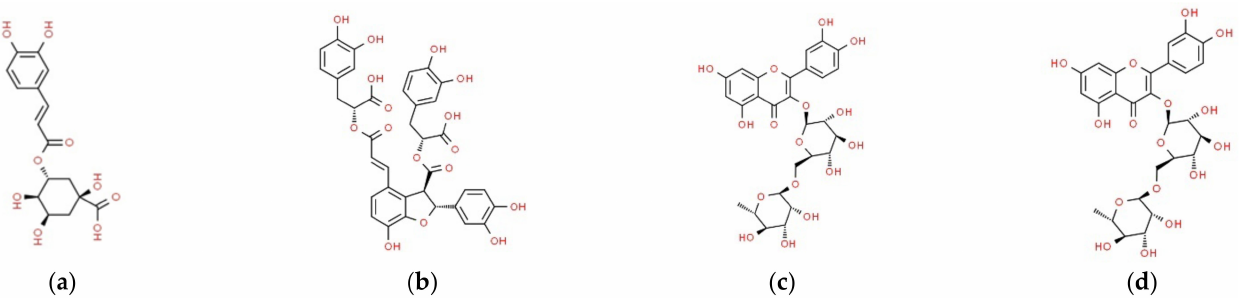
Figure 11. Structure of several reference substances. ( a ) Chlorogenic acid; ( b ) Salvianolic acid B; ( c ) Rutin; ( d ) Caffeic